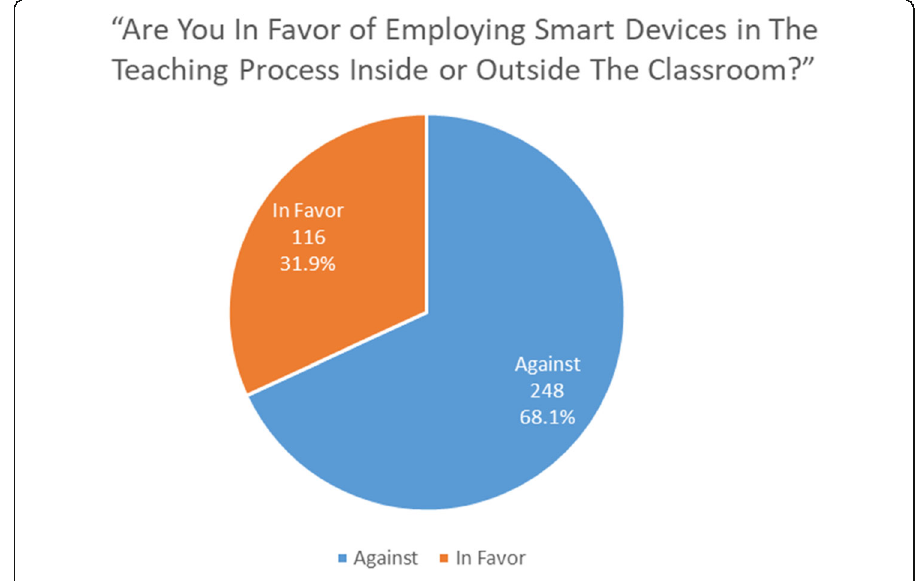
Fig. 3 Instructors ’ perceptions on the use of smart devices in the teaching and learning